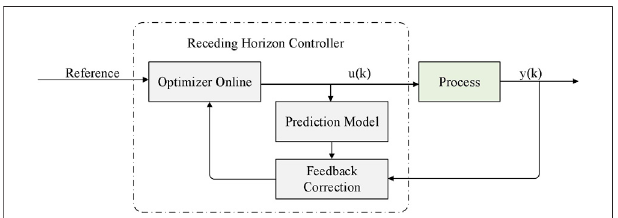
FIGURE 1 | Schematic block diagram of the MPC